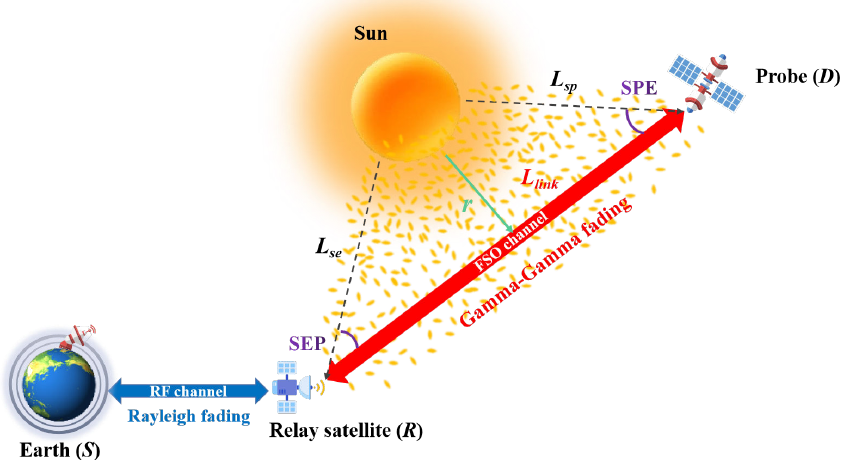
Figure 2. Diagram of deep space RF/FSO communication